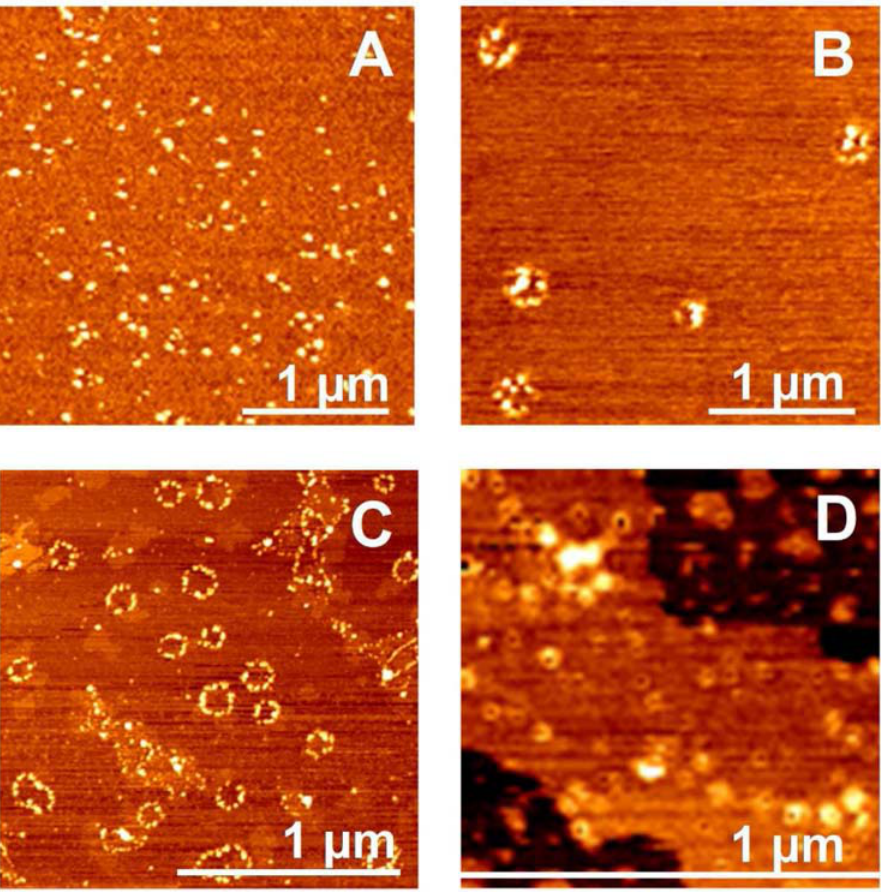
Figure 9. Annular and pore-like assemblies of Cu II -stabilized Ub oligomers. Topographic AFM images of Ub preincubated for two weeks at 37 u C with 3 mol equiv of Cu II in aqueous solution (A) and then dissolved in 20% TFE (B), in POPC liposomes (C), or in POPC planar bilayers (D).